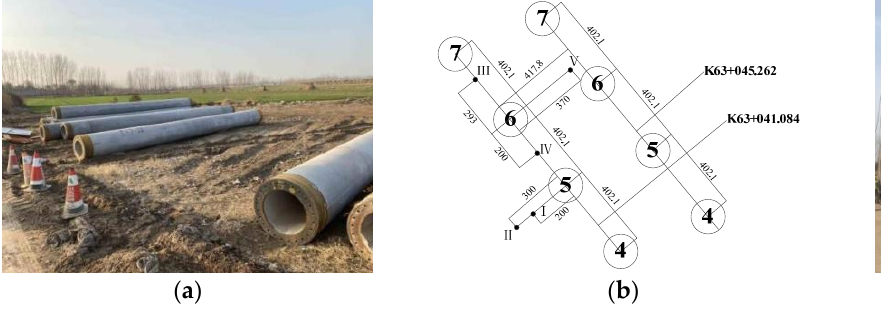
Figure 5. Field diagram of large diameter pipe pile penetration monitoring experiment, showing the ( a ) large diameter pipe pile, ( b ) rectangular pile arrangement, and ( c ) monitoring